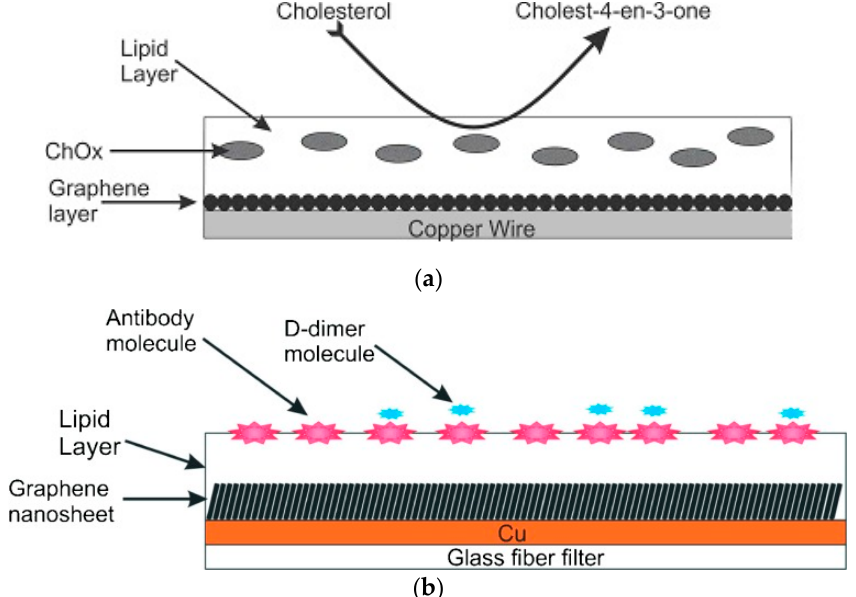
Figure 4. ( a ) Set-up of potentiometric experiments for the determination of cholesterol (from Reference [25] with permission). ( b ) Set-up of potentiometric experiments for the determination of D-dimer (from Reference [26] with permission).